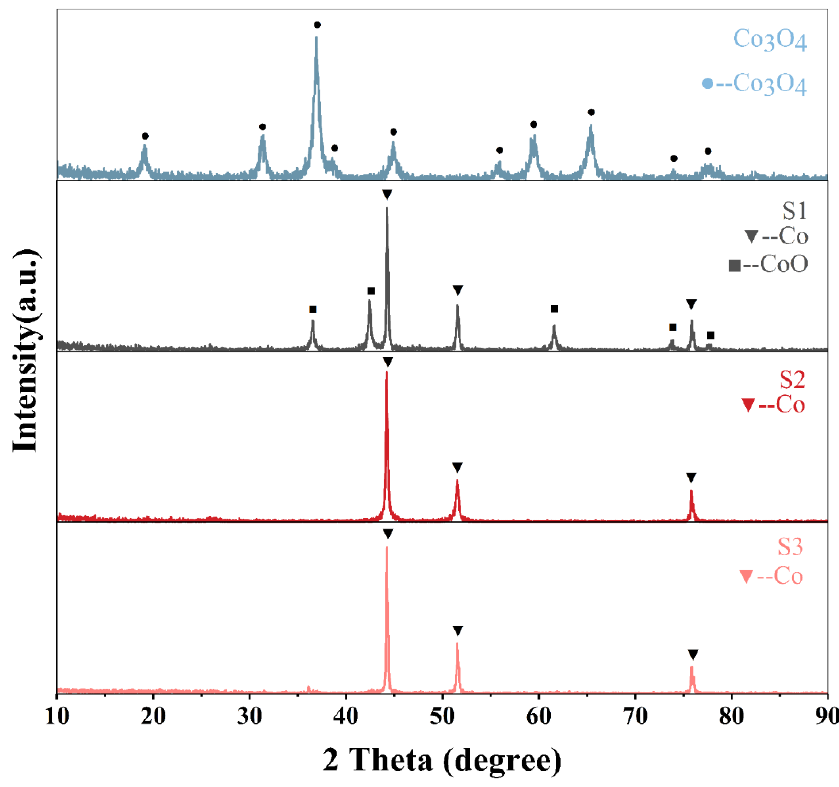
Figure 2. The XRD patterns of Co 3 O 4 , S1, S2, S3.